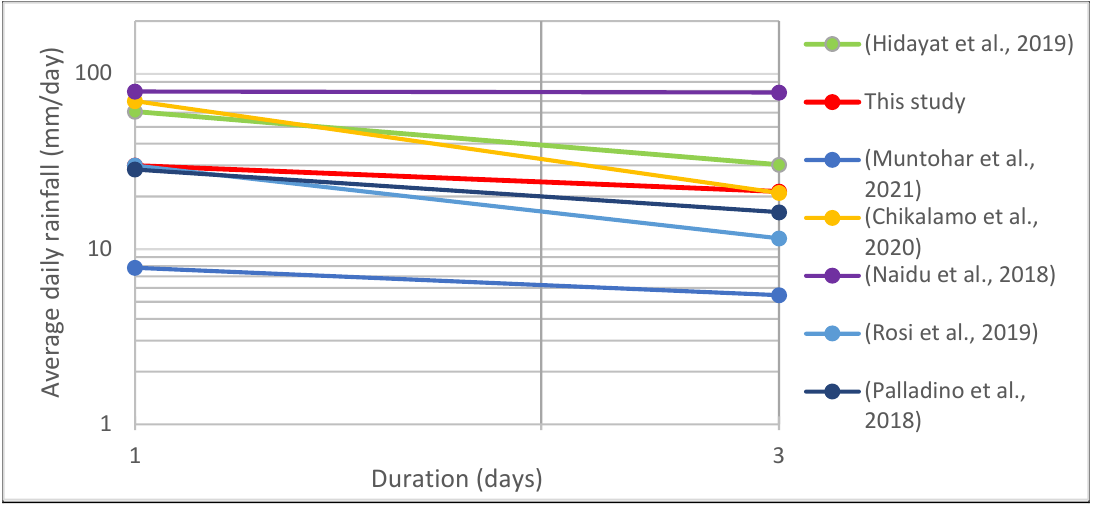
Figure 7. Worldwide rainfall thresholds triggering landslides, collected from 2018 to 2021 [8,39,45–47]. The landslide thresholds derived from average daily rainfall vary from less than 10 mm to more than 70 mm. This indicates that the landslide threshold is highly dependent on the location, climate, and method used for determining the threshold line [48]. High- land regions with natural steep slopes and lowland areas with artificial slopes will have a different rainfall intensity prior to a landslide, resulting in a different rainfall threshold.